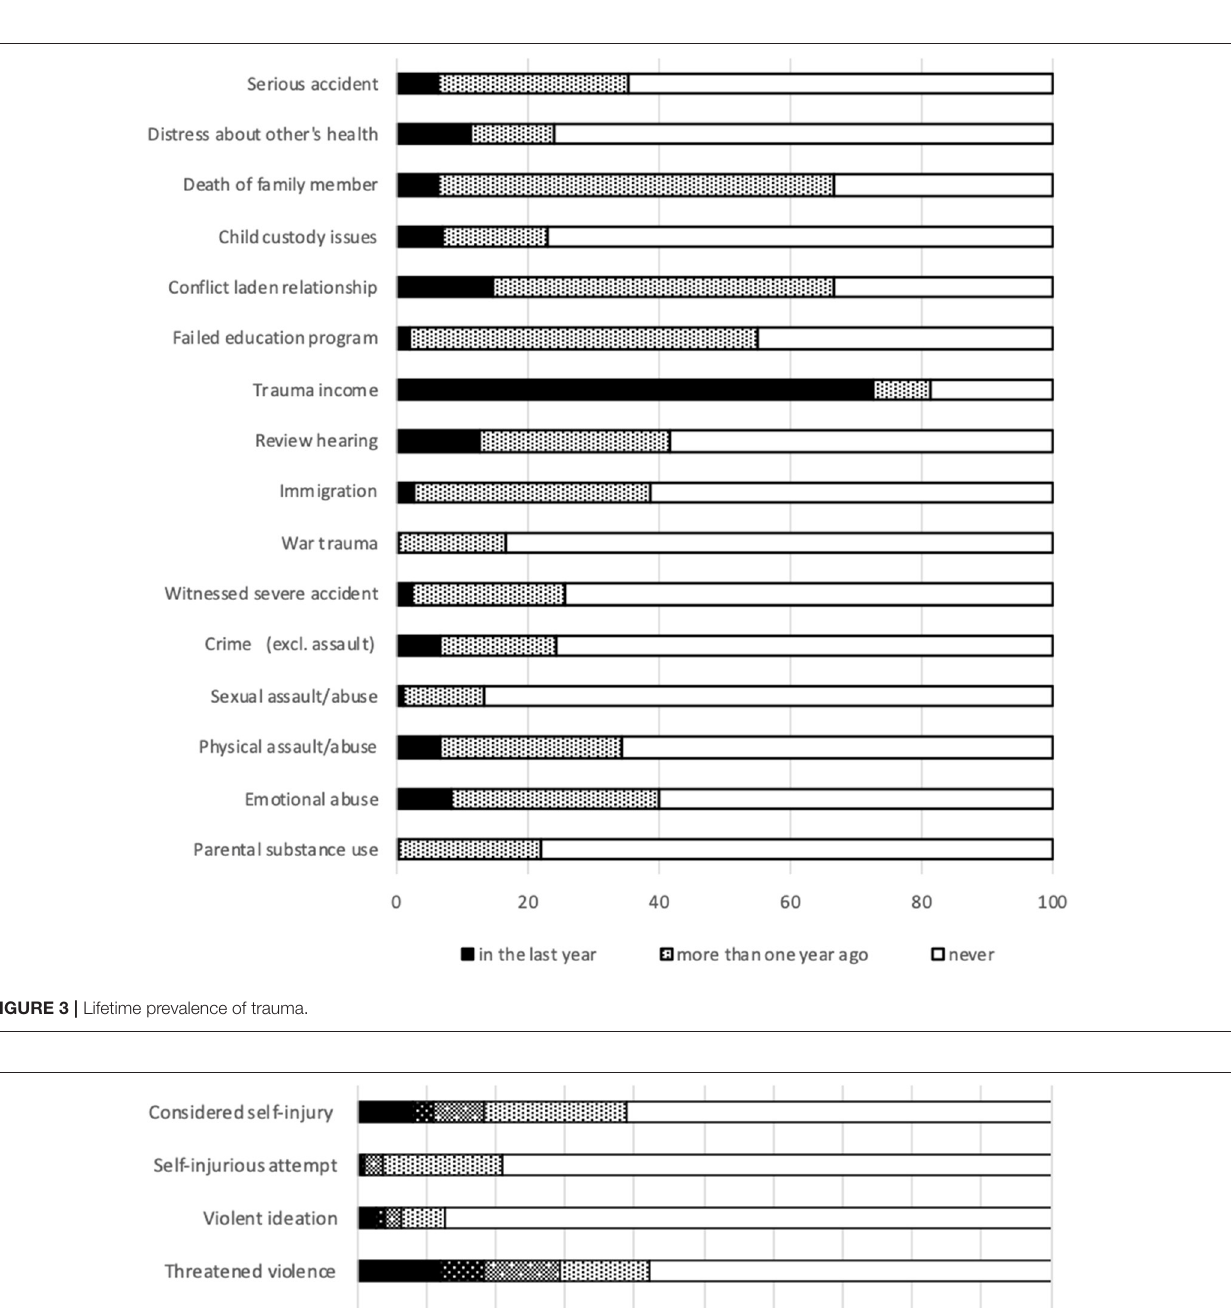
FIGURE 4 | Indicators of violent behavior.